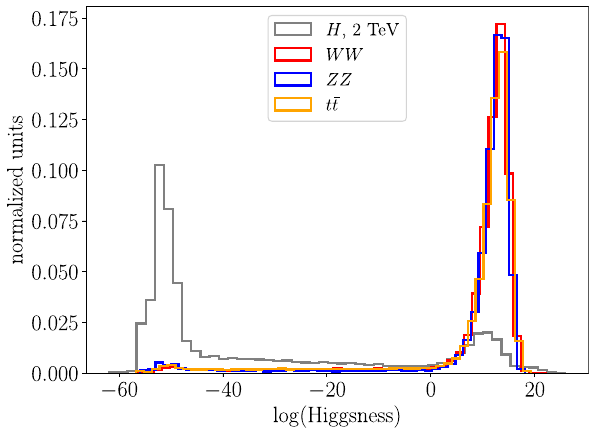
Fig. 2 The logarithm of the Higgsness variable defined in Eq. (3) for a 2 TeV Higgs boson and its SM